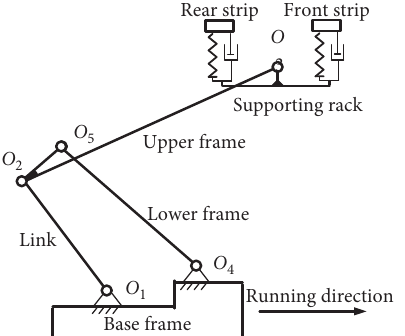
Figure 3: Main load-carrying components of the single-arm type pantograph.